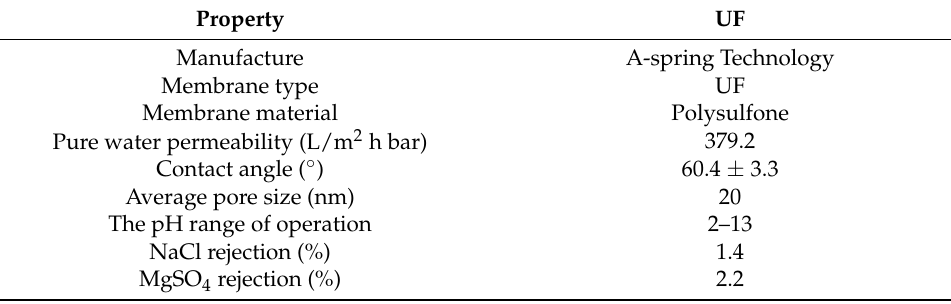
Table 1. Physicochemical characteristics of the PSf